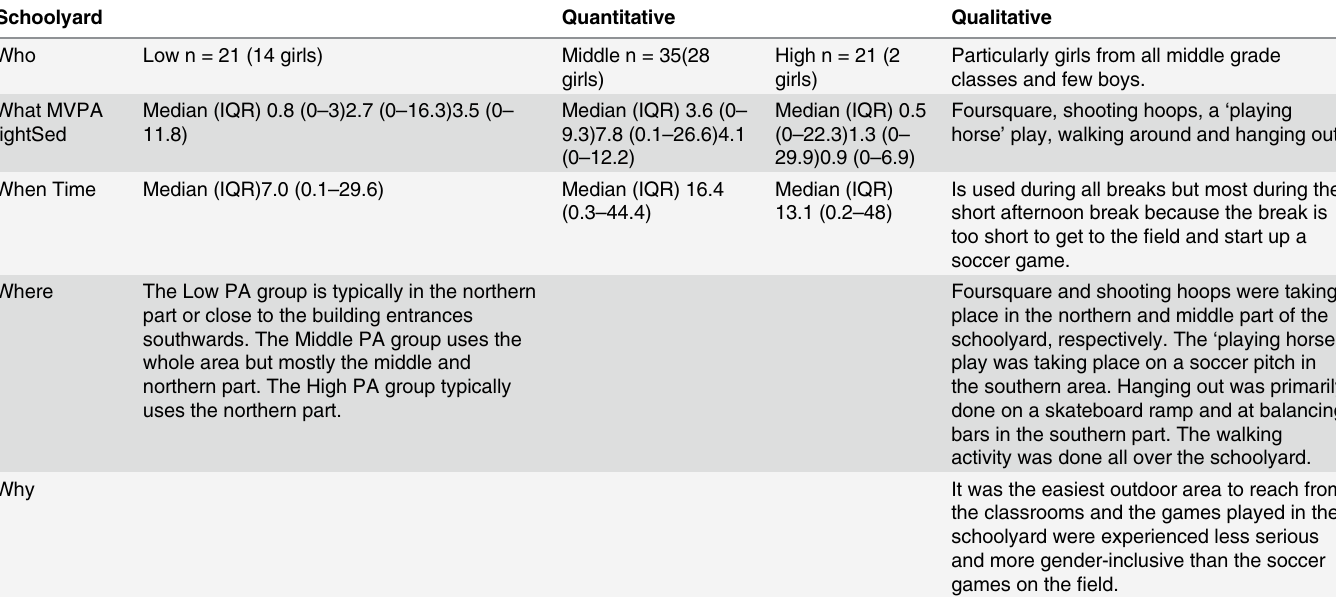
Table 2. Characteristics of time spent, activity level and behavior in the Schoolyard during